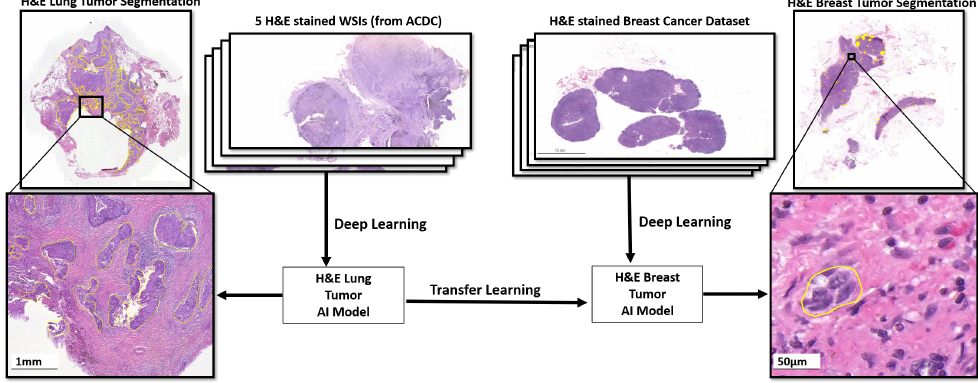
Figure 3. The H–E-stained breast cancer segmentation model is trained through transfer learning based on a lung tumor AI model which learned from five H–E WSIs of the IEEE ACDC challenge dataset. The pre-trained weights of the H–E lung tumor AI model are used as initial weights to train the proposed EBUS-TBNA lung tumor AI model for the segmentation of the H–E-stained breast